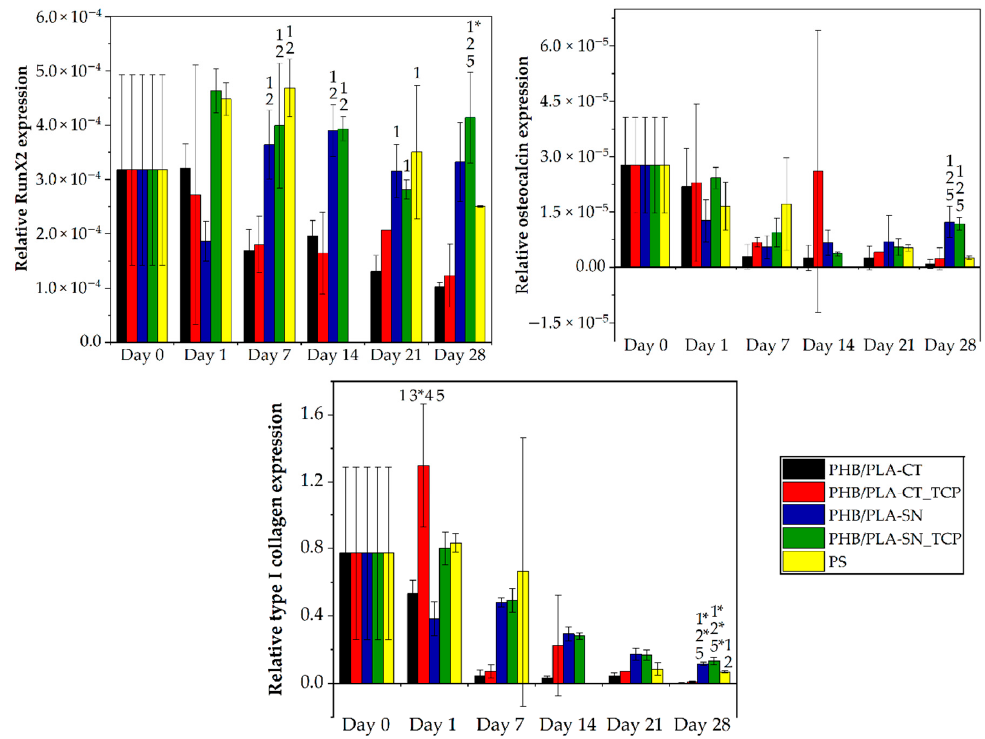
Figure 8. Gene expression of osteogenic markers RunX2, collagen I and osteocalcin. The numbers above the column indicate statistically significantly higher values compared to the column of that number for p < 0.05 and p < 0.001 with *.